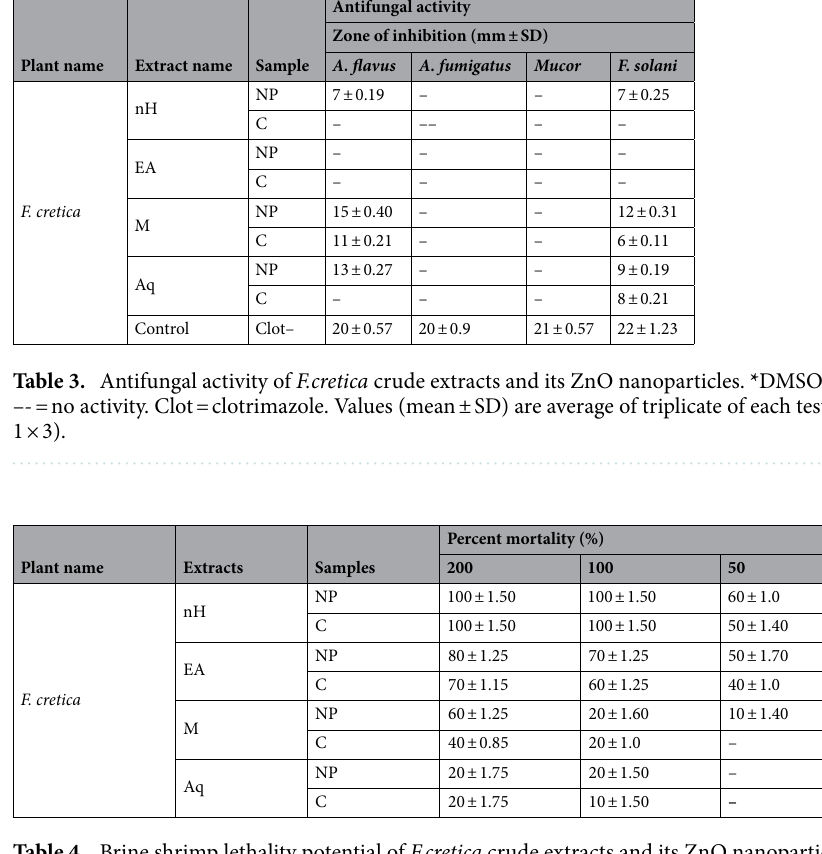
Table 4. Brine shrimp lethality potential of F.cretica crude extracts and its ZnO nanoparticles. * Values given are expressed as a mean of triplicate ± SD. Positive control = Doxorubicin (5.93ug/ml). Negative control = DMSO. * LC 50 of positive control (Doxorubicin) was 5.93 µg/ml. DMSO was applied as negative control and the values given are expressed as a mean of triplicate ± SD.